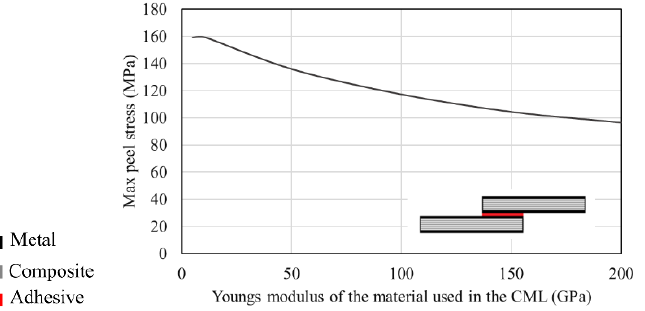
Figure 23. Effect of the Young ’s modulus of the metal laminate used in CML on maximum peel stress. Adapted from [158].